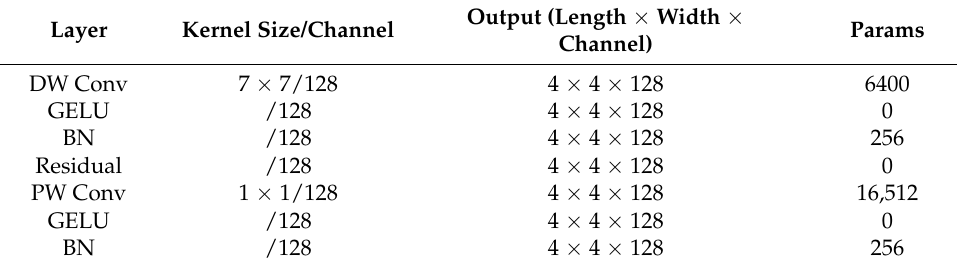
Table 2. Specific parameters of